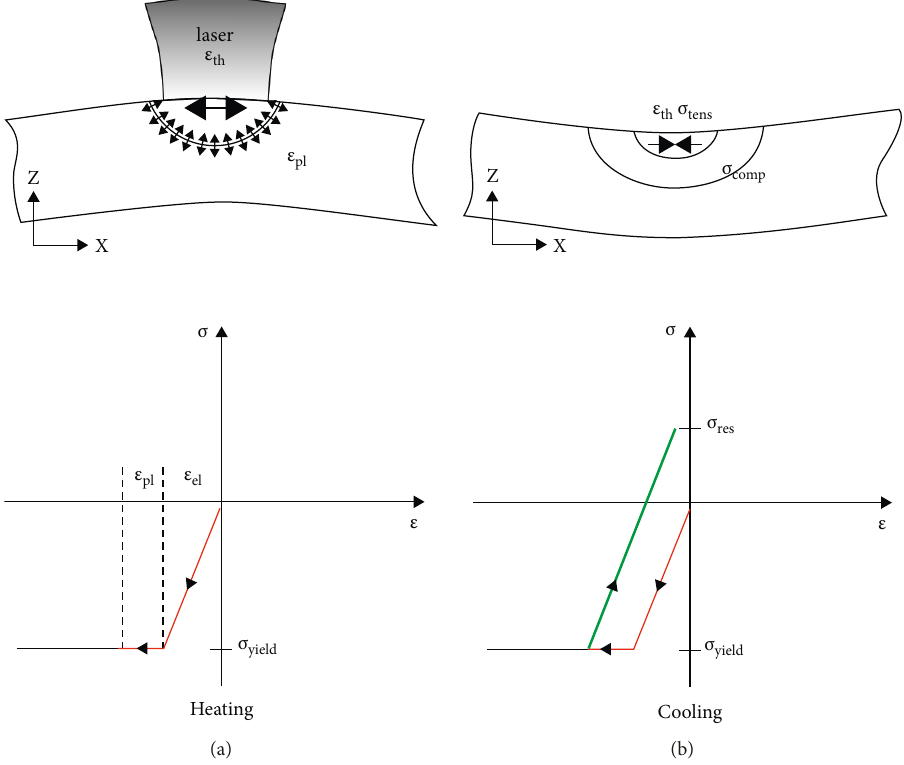
Figure 2: Mechanism of temperature gradient (TGM). Stresses and deformation during heating (a) and cooling down (b) in the irradiated zone Table 1: SLM process parameters used to build samples. S. no.